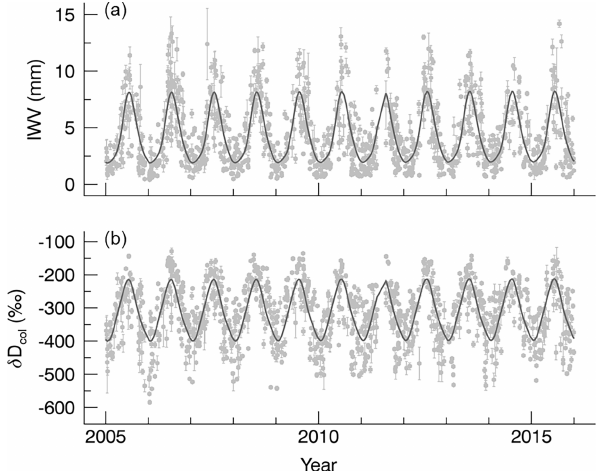
Figure 2. Daily mean time series of (a) integrated water vapor and (b) column-based δ D retrieved from Zugspitze FTIR measure- ments. Error bars indicate uncertainties of daily means ( ± 2SE), and grey lines show corresponding seasonal cycles (fitted third-order Fourier